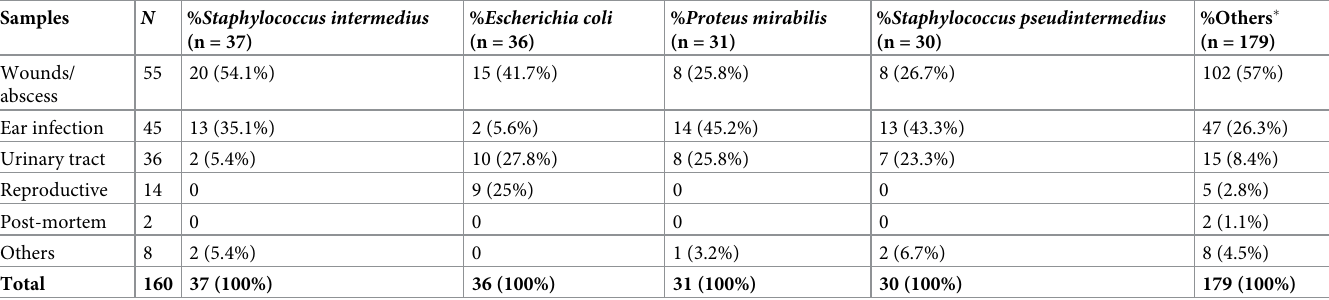
N - Total number of clinical samples; n- Total number of bacterial isolates. �